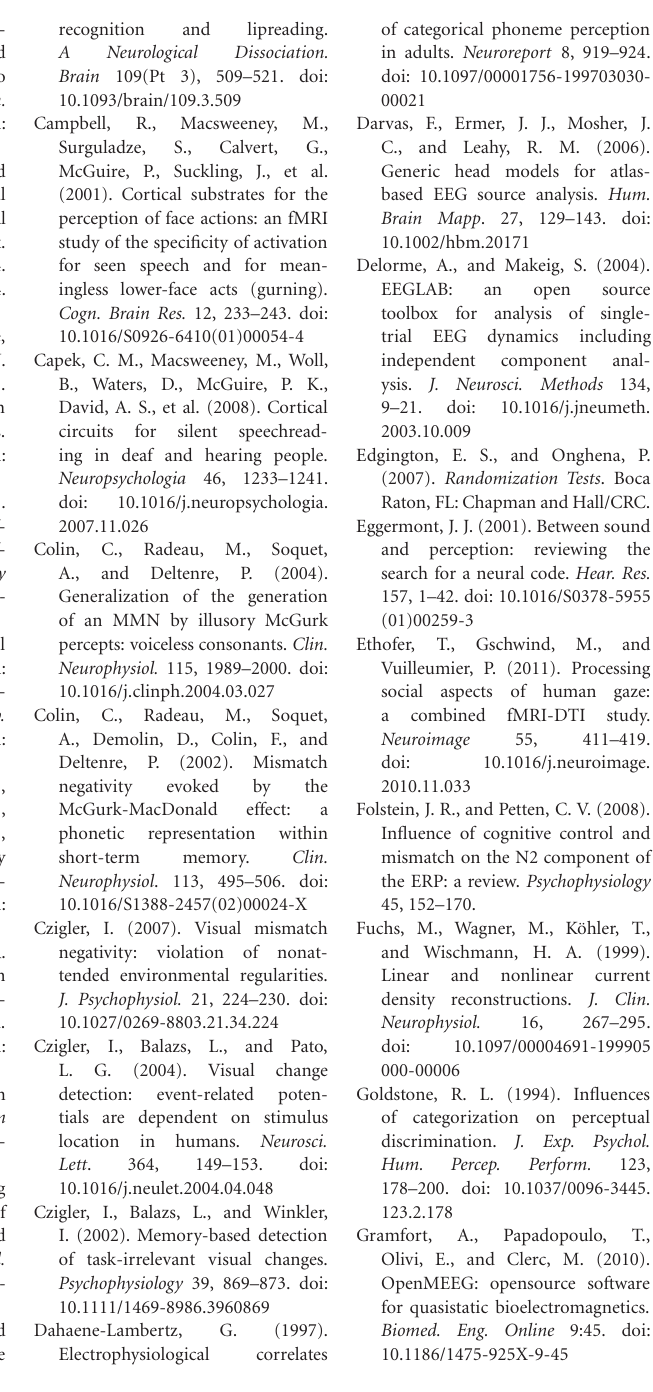
activity is scattered and transient, but there are hotspots of activity in inferior frontal cortex from 200 to 240ms, in fronto-central cortex from end of the interval depicted. Figure S6 | Source images for “zha” far vMMN. Images show the depth-weighted minimum norm estimate of dipole source strength constrained to the surface of the cortex using a boundary element forward model and a generic anatomical model at 20-ms intervals from